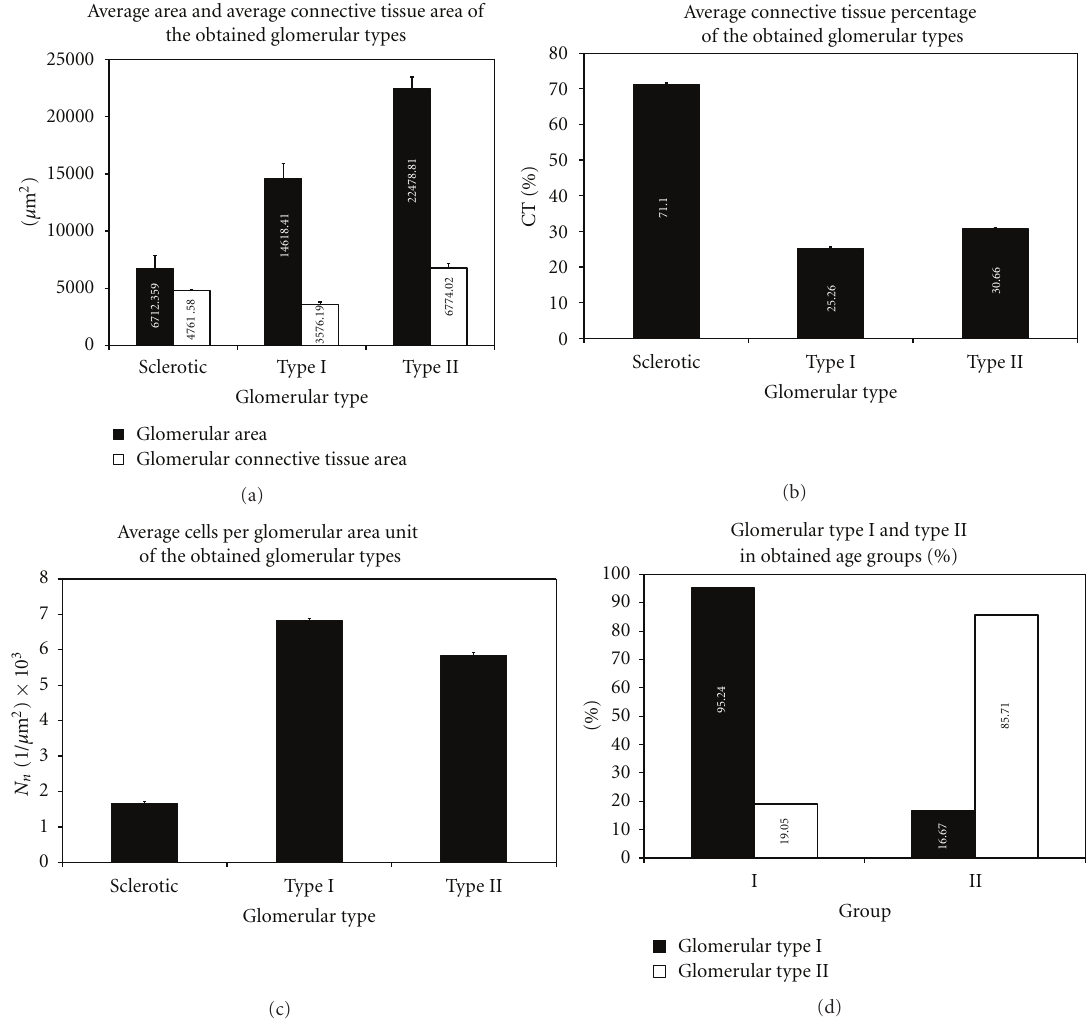
Figure 2: Morphometric characteristics of sclerotic, type I (normal) and type II (hypertrophic) glomeruli in evaluated cases; (a) average glomerular area and average glomerular connective tissue area; (b) average glomerular connective tissue percentage; (c) average number of cells per glomerular area; (d) percentage of type I (normal) and type II (hypertrophic) glomeruli in obtained age